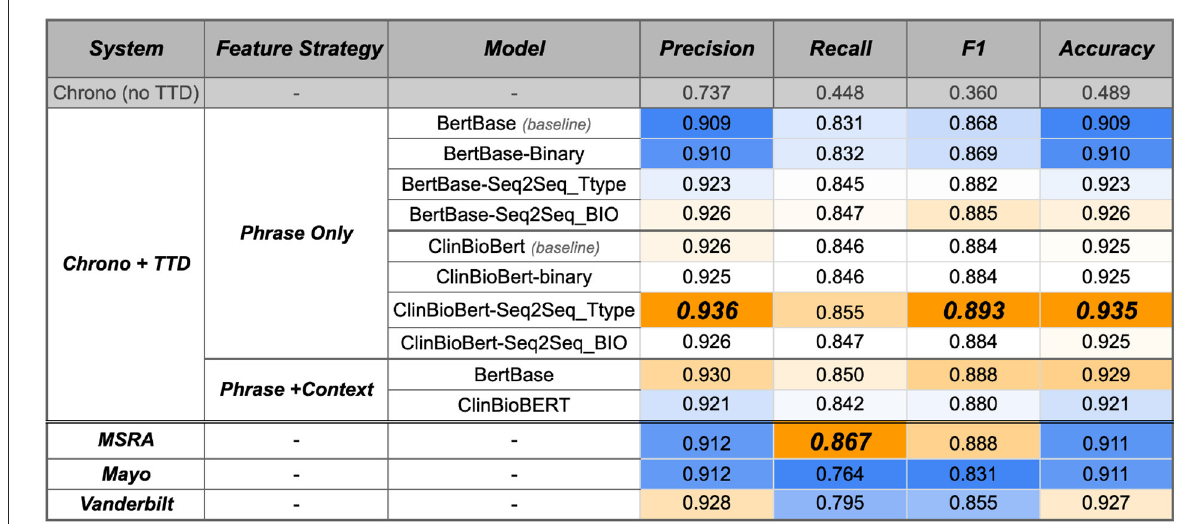
FIGURE8 System performance on the RelIV-TIMEX Evaluation data set of Chrono before and after the TTD model integration, and the three i2b2 state-of-the-art system using class-based P, R, and F1 metrics. Values are the weighted average bootstrap estimates across individual DATE and DURATION performance (Supplementary Table 5 contains the 95% confidence intervals). Bold, best performance across all SVM models; orange, high; white, median; blue, low scores with the maximum and minimum relative to each column instead of the entire table.